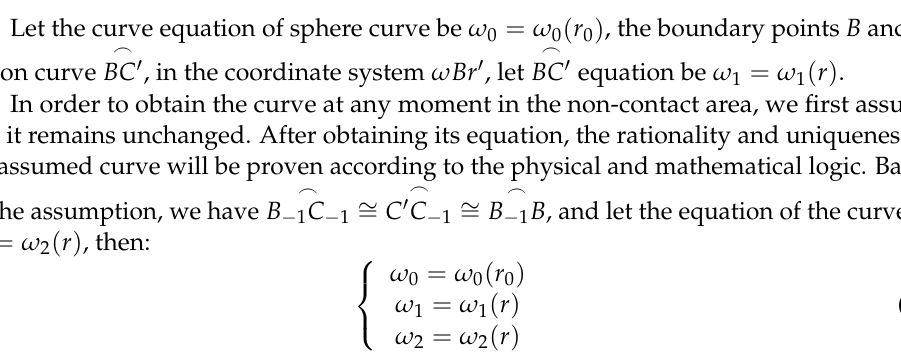
Figure 3. The deformation curve of collision interface in non-contact area.